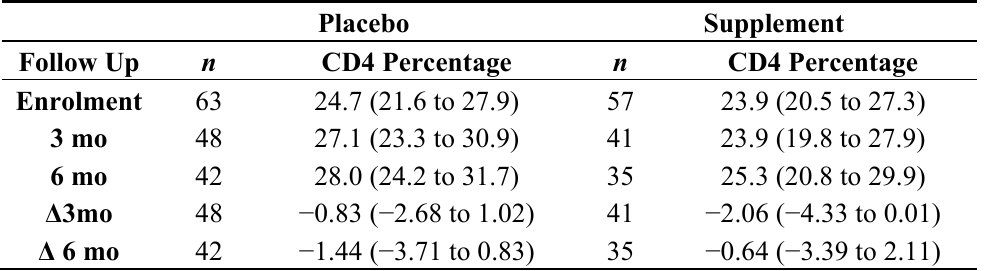
Table 2. Immunological status of children during intervention period # .